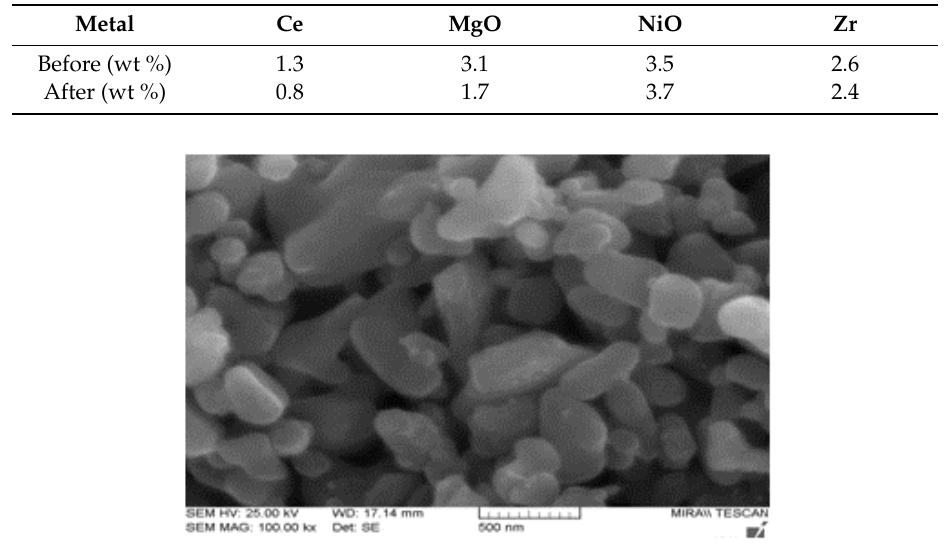
Table 4. Composition of the 3 wt% Ni / Ce-ZrO 2 / Al 2 O 3 catalyst before and after reforming.